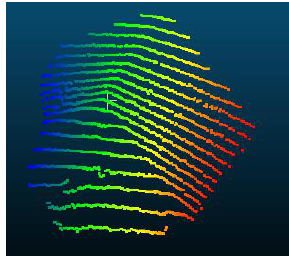
Figure 5. LIDAR 3D point cloud of the target